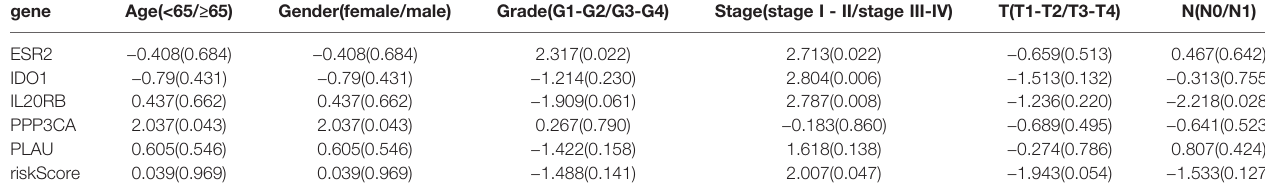
TABLE 1 | Relationships between the expressions of the immune-related genes (IRGs) and risk score and the clinicopathological factors in pancreatic adenocarcinoma: t(P). gene